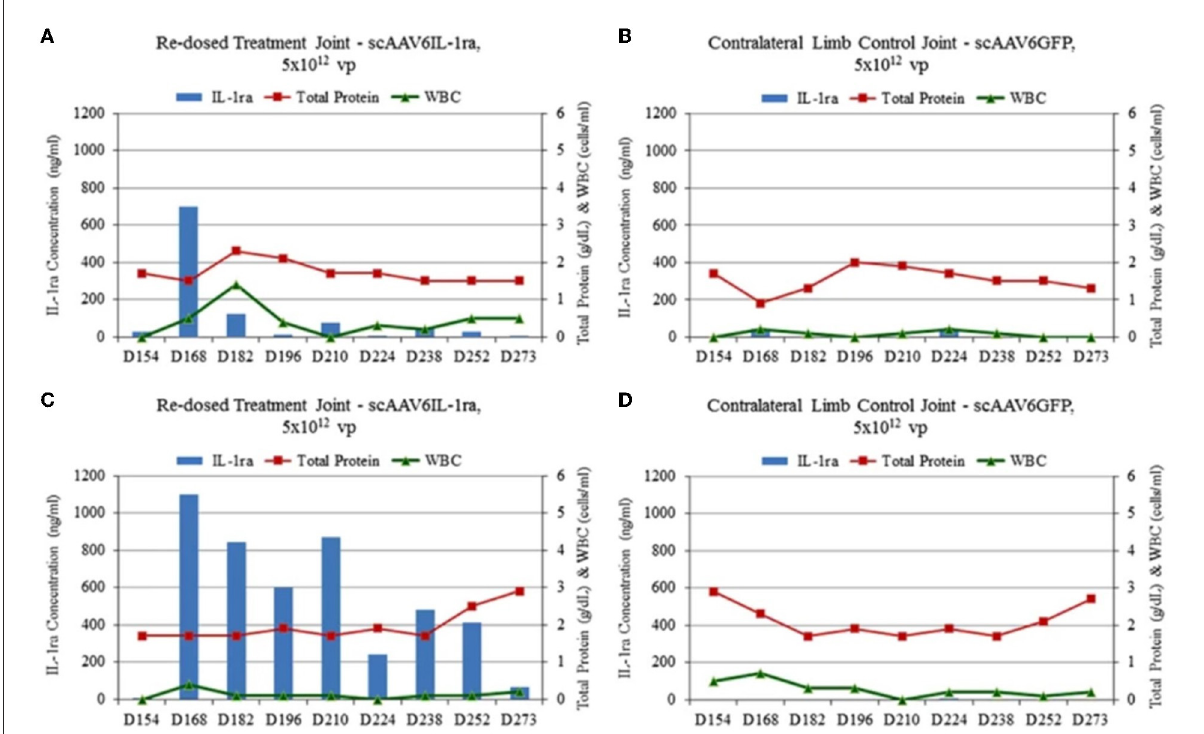
FIGURE5 (A–D) IL-1Ra (ng/ml), total protein (g/dl) and WBC (cells/ml) levels in low dosed and control limb synovial fluid samples after redosing at Day 154. One horse (A) whose joint was re-injected had IL-1Ra level sharply increase to 675ng/ml and decline rapidly while the other horse (C)